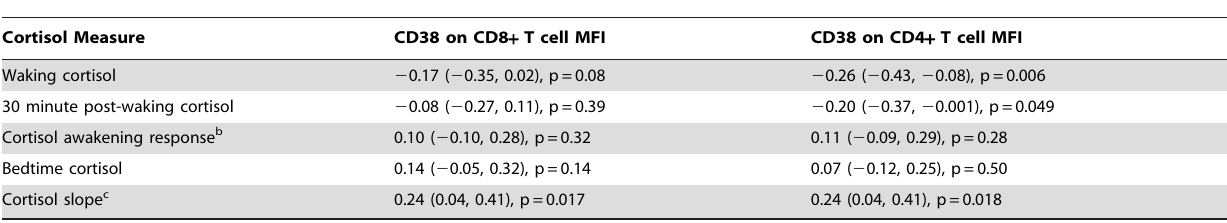
Table 2. Correlations of T cell activation measures with cortisol measures a